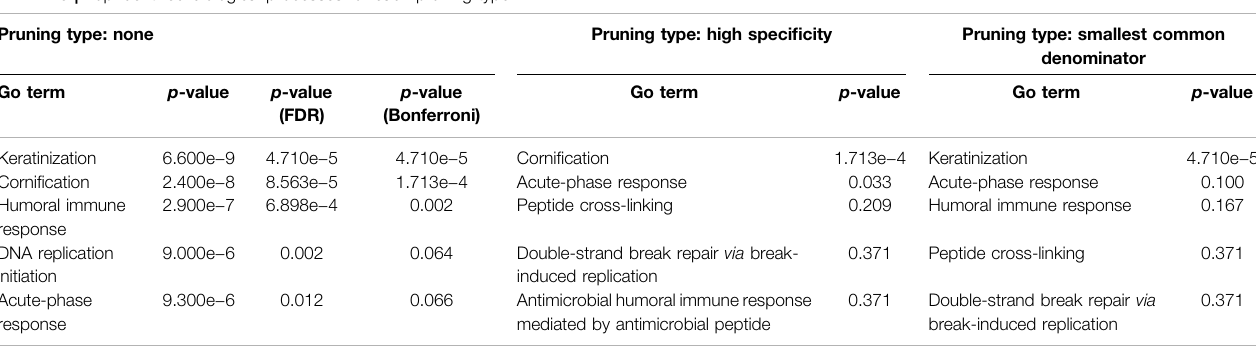
TABLE 3 | Top identi fi ed biological processes for each pruning type.